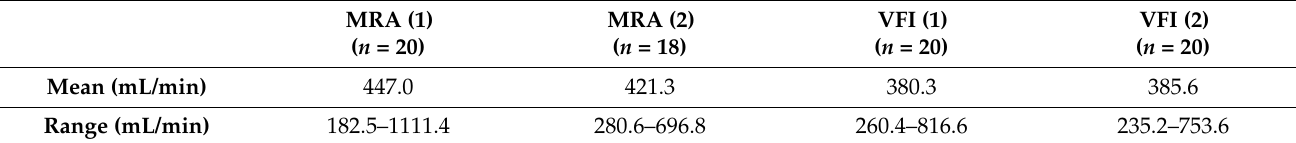
Table 1. Mean and range of the replicated MRA and VFI estimations. (1) represents the first acquisition and (2) the second.